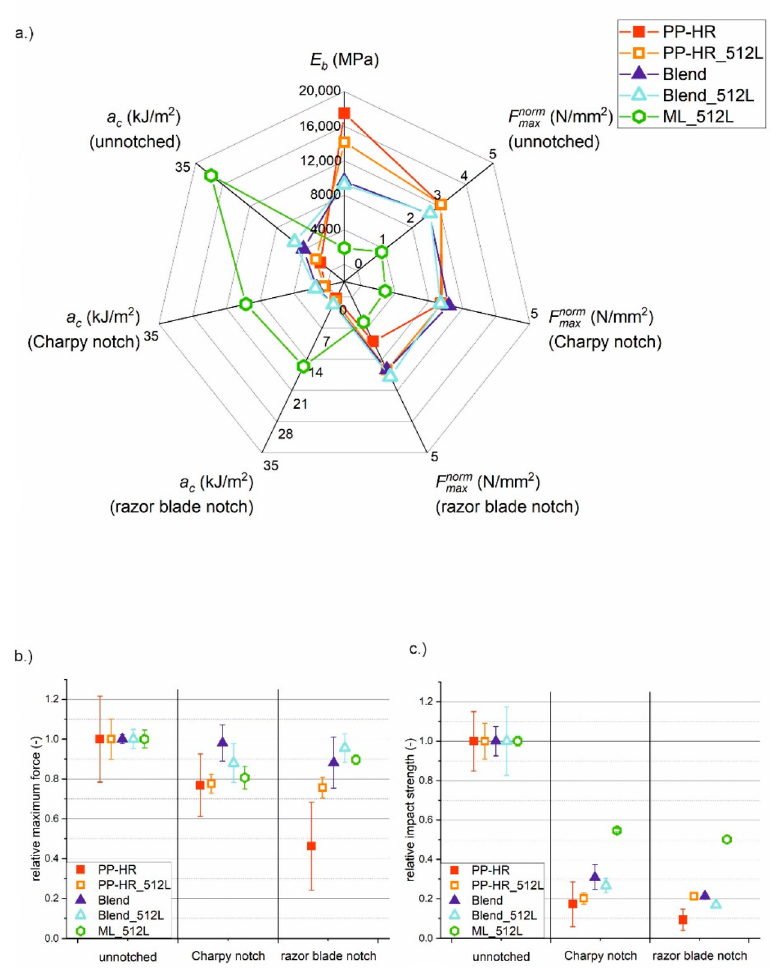
Figure 4. ( a ) Overview of E b , F norm max and a c for unnotched, Charpy-notched and razor blade notched specimens of all tested materials. The notch sensitivity and data scattering of ( b ) F norm max and ( c ) a c is depicted by referencing each value to the unnotched state of that